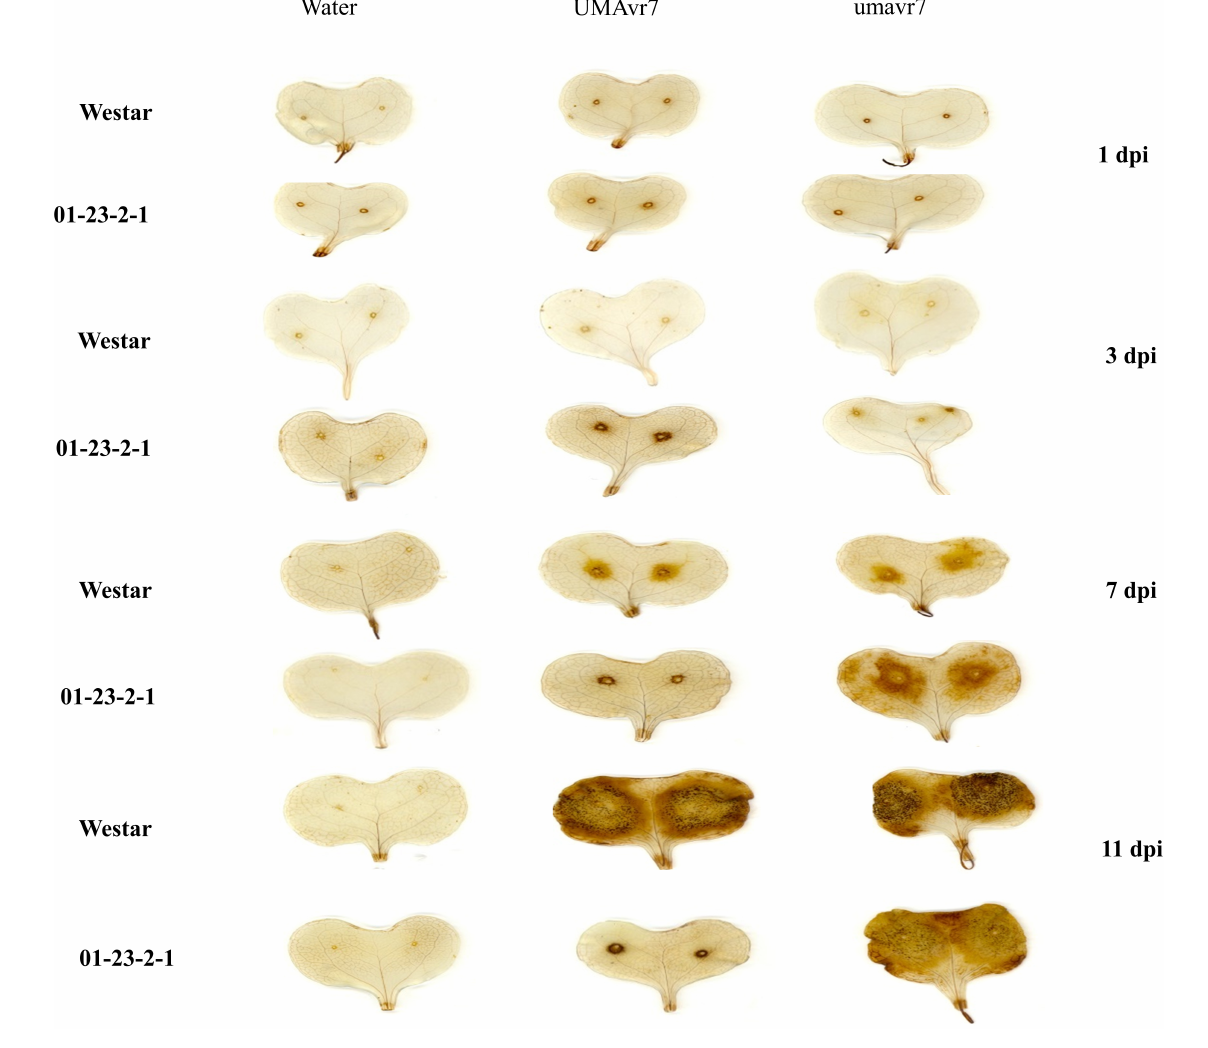
FIGURE 5 | Cotyledons inhibiting H 2 O 2 in response to Leptosphaeria maculans isolate UMAvr7 and umavr7 infection, and corresponding stage of cotyledons inoculated with water were set as controls. In situ detection of H 2 O 2 was performed using DAB staining in the Westar and 01-23-2-1 at 1, 3, 7, and 11 days post inoculation,